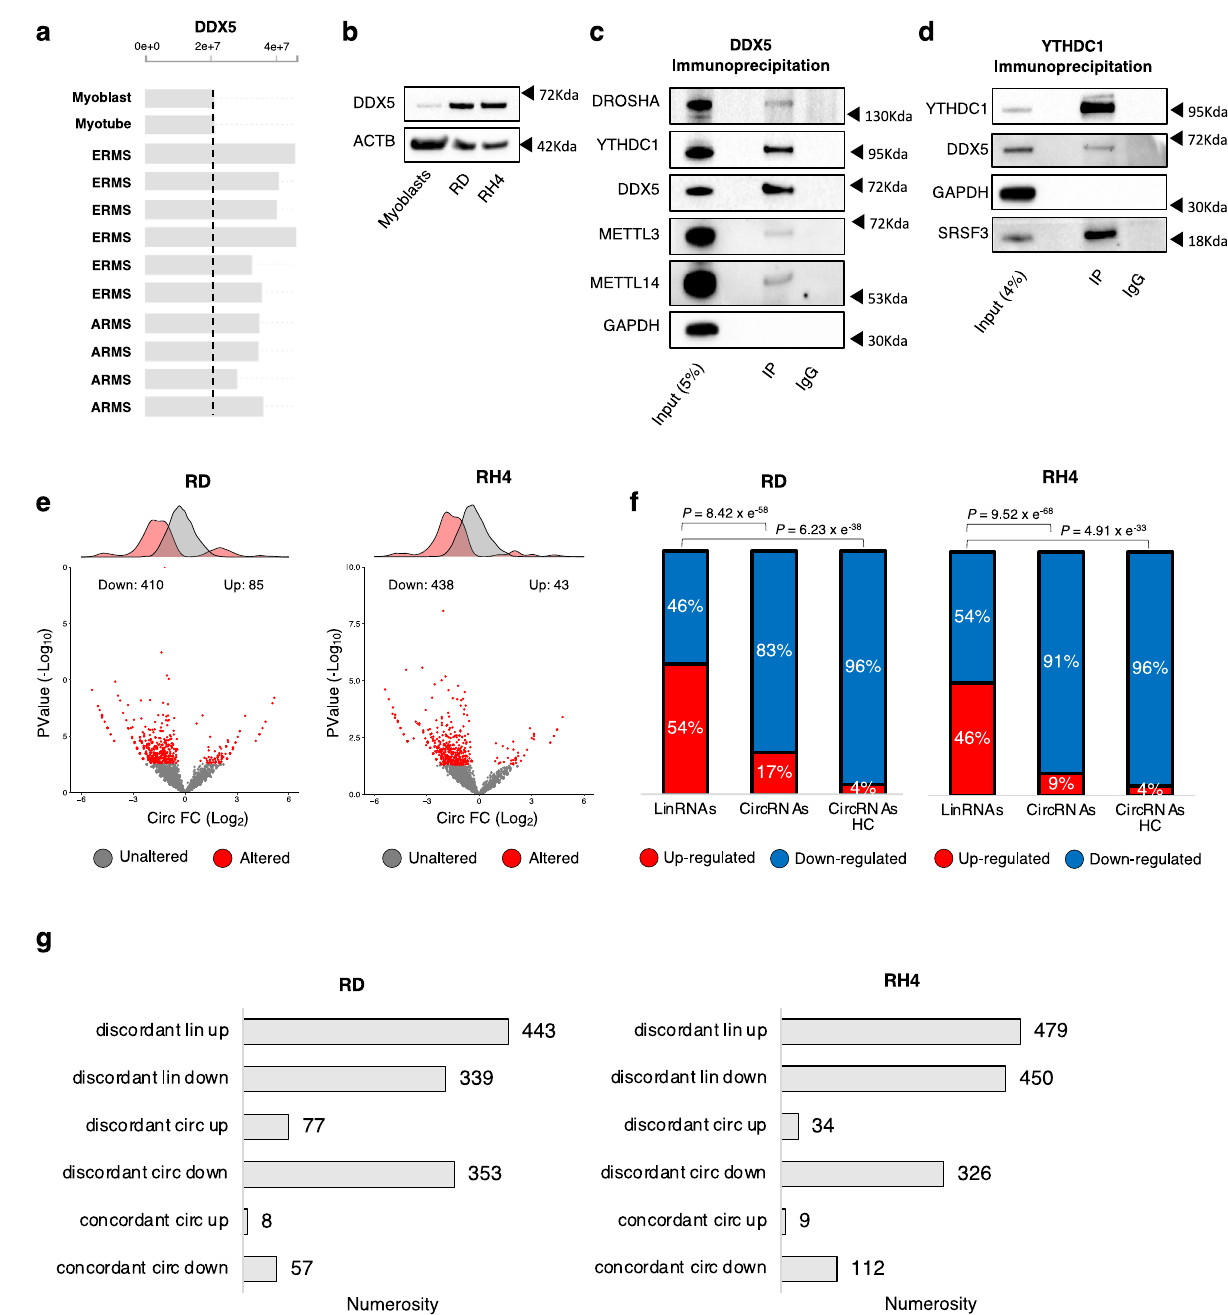
Fig.4|DDX5helicasecontrolscircRNAexpressionandinteractswithYTHDC1. a Protein levels for DDX5 in orthotopic RMS patient-derived xenografts, as com- pared to normal myoblasts and myotubes. Data derive from https://pecan.stjude. cloud/proteinpaint/study/RHB2018. A vertical dashed line indicates the level of proteinexpressionofDDX5innormalmyoblasts. b Representativewesternblotto evaluate the levels of DDX5 in wild-type myoblasts, RD, and RH4 cell lines; ACTB was used as loading control. n =3 biologically independent replicates. c Representative western blot analysisof DDX5 immunoprecipitation from whole- cell lysate in RD cells. The percentage of input is indicated. DROSHA and GAPDH were used as a positive and negative control for the co-immunoprecipitation, respectively. n =2 biologically independent replicates. d Representative western blot analysis of YTHDC1 immunoprecipitation from whole-cell lysate in RD cells. Thepercentageofinputisindicated.SRSF3andGAPDHwereusedasapositiveand negative control for the co-immunoprecipitation, respectively. n =2 biologically